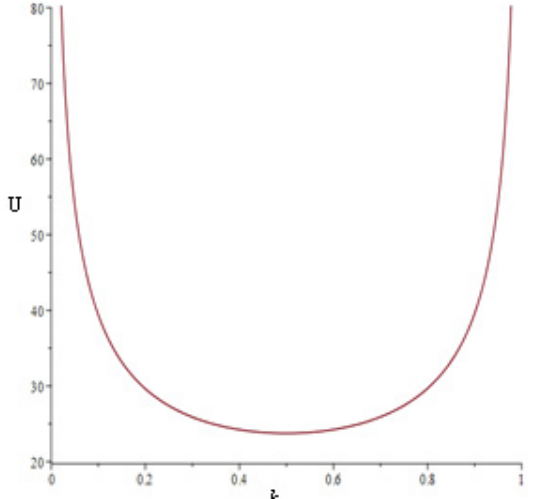
Figure 3. Graph of acoustic velocity versus low air concentrations. SI speeds. For low concentrations of water in the air